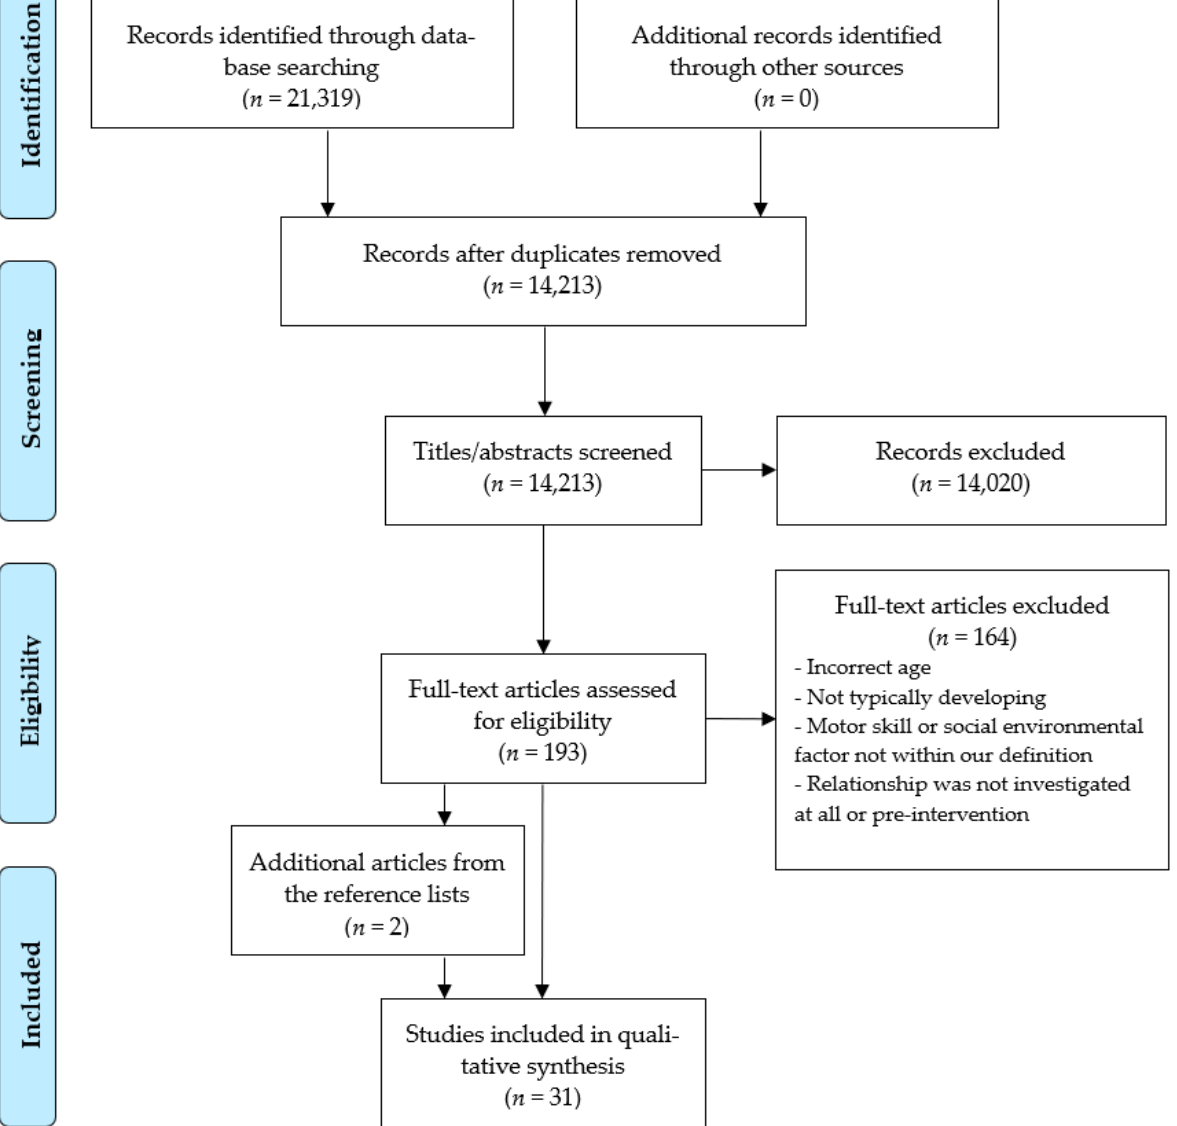
Figure 1. PRISMA flow diagram [25] of the study selection process to identify eligible studies for the systematic review.